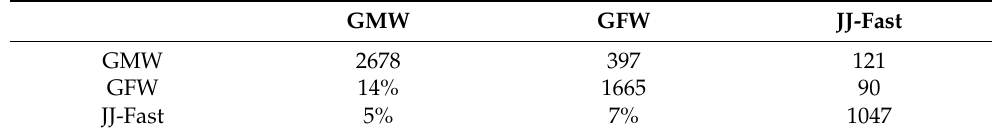
Table 5. The 1 km hexagon intersections between the GMW Mangrove Loss Alerts (this study), the JJ-Fast alerts [34] and GFW alerts [32,33]. This revealed a low correspondence between the three datasets, with only 14% of the GMW Mangrove Loss Alerts intersecting with the GFW and only 5% of the JJ-FAST and GMW alerts intersecting. GMW GFW JJ-Fast GMW 2678 397 GFW 1665 JJ-Fast